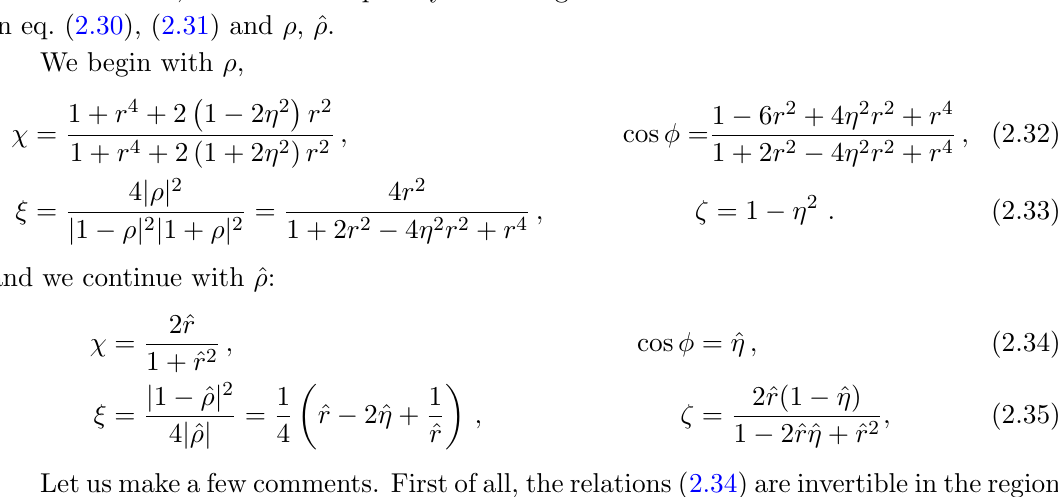
(cid:16) ) | see (cid:0)